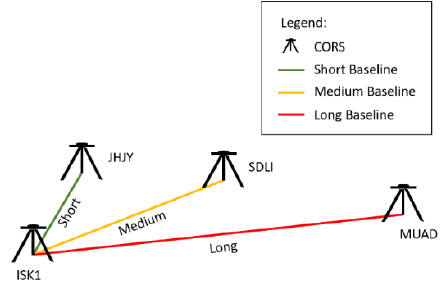
Figure 1. Short, medium and long baselines.